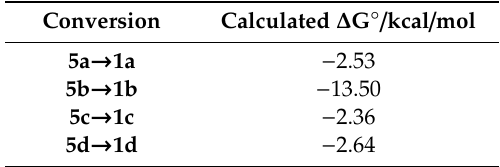
Table 2. Calculated ∆ G ◦ for tautomeric conversion 5 → 1